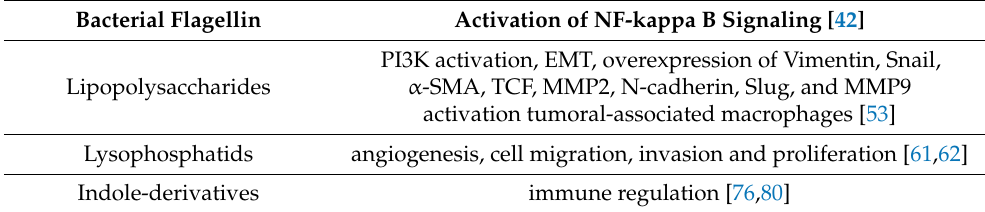
Table 1. Effects of bacterial metabolites on ovarian cancer. Bacterial